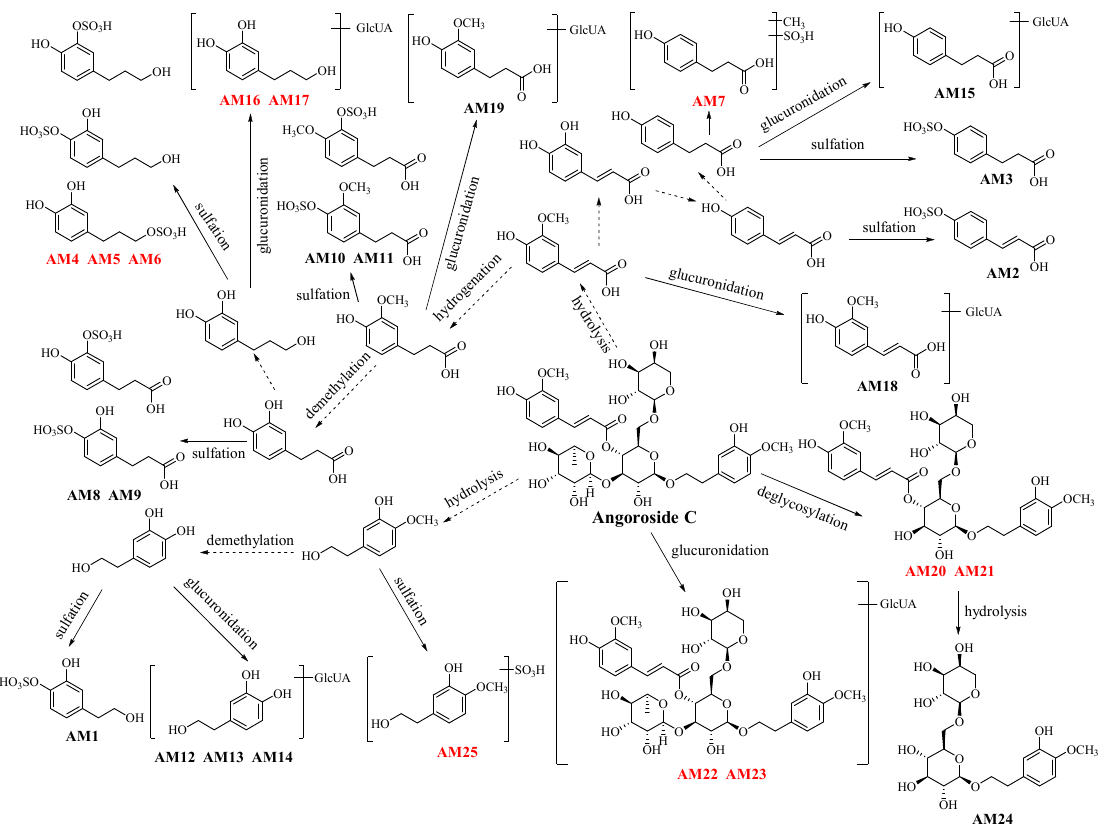
Figure 4. The metabolites and metabolic pathways of angoroside C in rats.